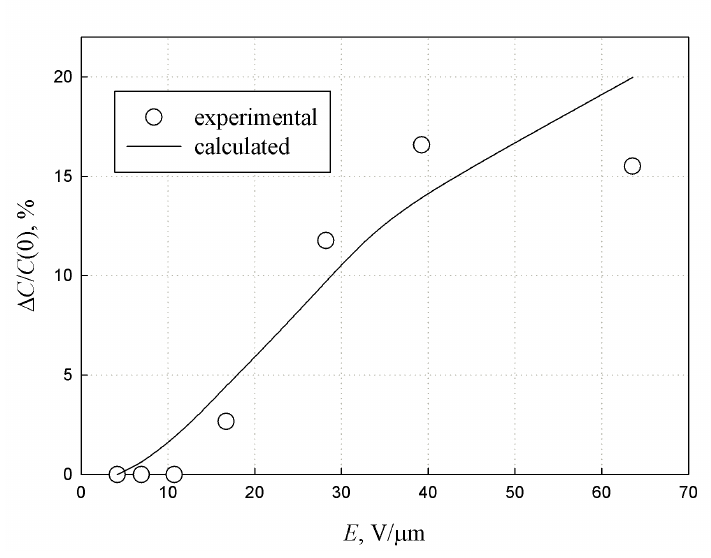
Figure 4. Capacitance shift versus microwave signal field